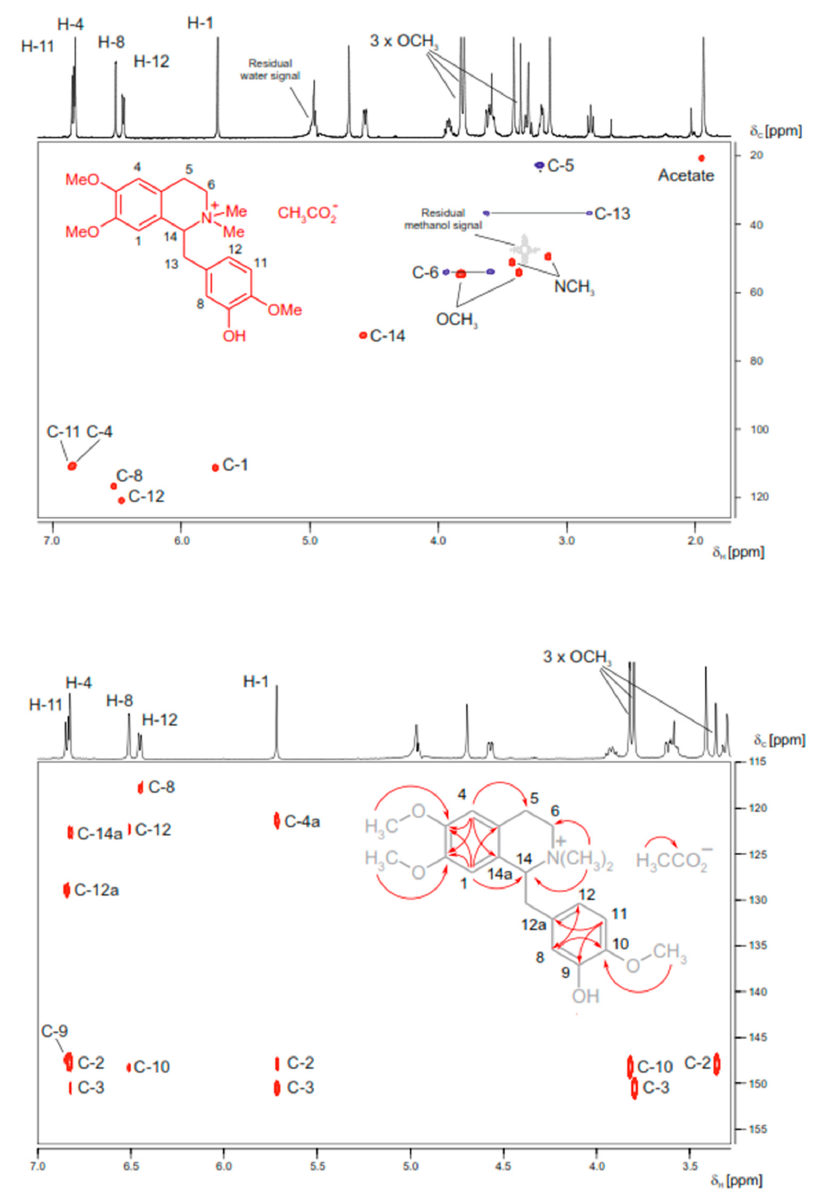
Figure 4. HPLC-SPE-NMR-derived HSQC (top figure) and HMBC (bottom, figure) spectra of N - methyllaudanidinium acetate (structure see formula insert); a secondary metabolite found in Corydalis solida tubers. Online structure elucidation was facilitated from an aliquot of an alkaloid-enriched solid phase extraction fraction (2.1 mg) obtained from the methanolic extract (93 mg) of a single 233 mg Corydalis solida tuber. The NMR spectra were obtained in deuterated methanol on a 600 MHz NMR spectrometer, equipped with a 30 µL cryofit insert fed into a 3 mm DUI cryoprobe. HSQC (6-hour acquisition time): Red cross-peaks are stemming from CH and CH 3 protons, blue cross peaks from CH 2 protons. Residual solvent signals are given in grey. HMBC (12-hour acquisition time): The correlation information derived from the marked cross-peaks is summarized in the formula insert. Adapted from Sturm et al. [110] with permission from Elsevier.